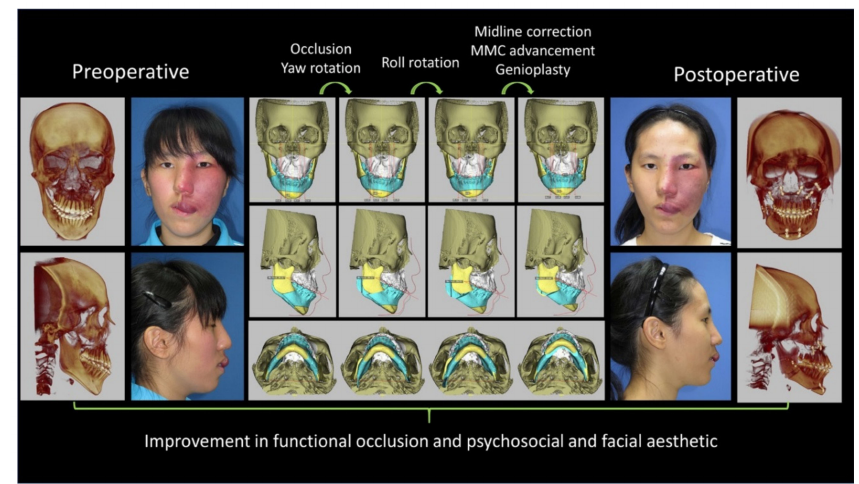
Figure 4. Case of a 16-year-old girl with Sturge Weber syndrome with a left face vascular malformation. The involvement of skeletal and soft tissues was extensive. She had received several sclerosing agent injections and laser treatments to reduce the vascular lesions. She experienced an episode of prolonged bleeding after a tooth extraction. Her facial deformity was characterized by left facial overgrowth and malocclusion with anterior open bite. Computed tomography angiography showed localized hypervascularity but no intracranial vascular malformation. Three-dimensional simulation was performed for surgical planning. She received Le Fort I, bilateral sagittal split of the ramus, genioplasty, and reduction of the left zygoma and buccal fat pad. Intraoperative blood oozing was noted, but was under control. Postoperative intermaxillary immobilization was not required, and the course was uneventful. One year later, she received the second stage of soft tissue reduction. The patient and her parents were satisfied with the treatment. (MMC: maxillomandibular complex). Patient provided written consent for the use of her image.